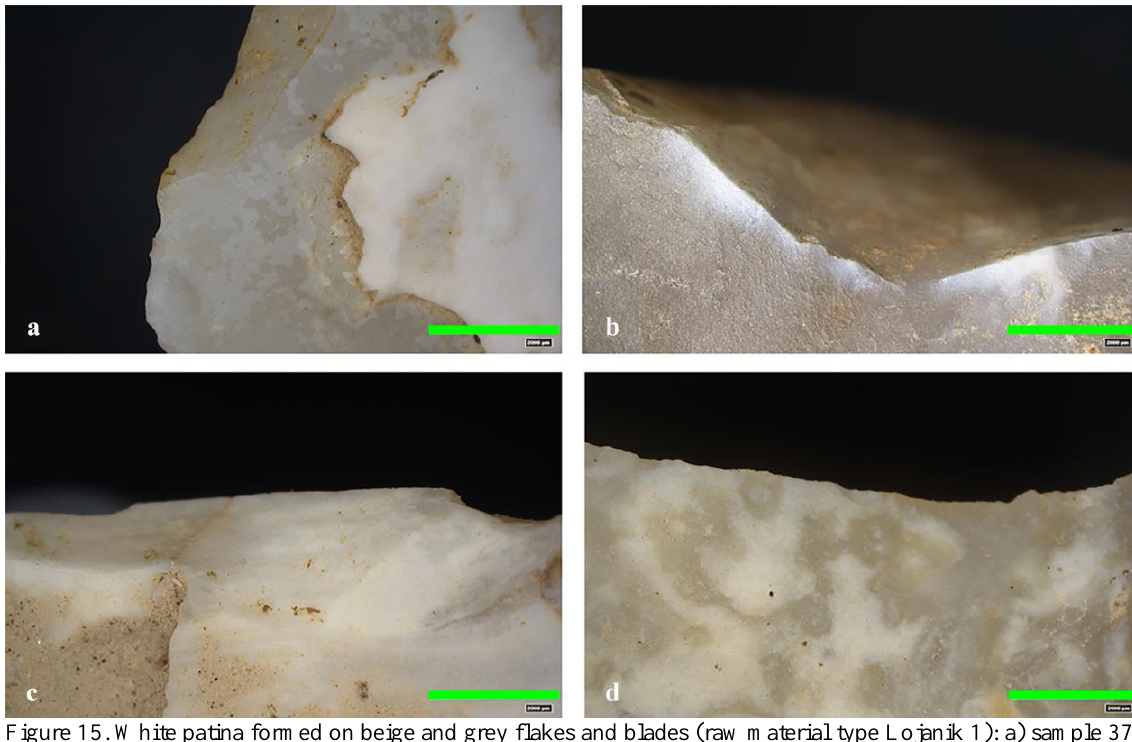
Figure 15. White patina formed on beige and grey flakes and blades (raw material type Lojanik 1): a) sample 37, flake; b) sample 36, flake; c) sample 37, flake, d) sample 37, blade, all from trench C, scale bar equal to 2000